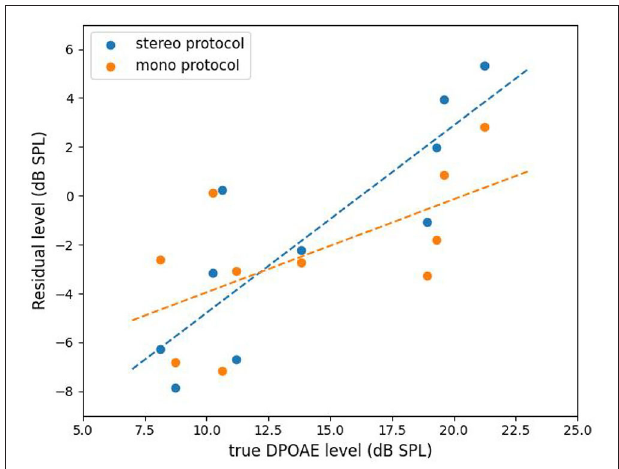
FIGURE 7 | The residual level vs. the true DPOAE level with stereo and mono protocols, respectively. The dashed lines are least-square fits to the